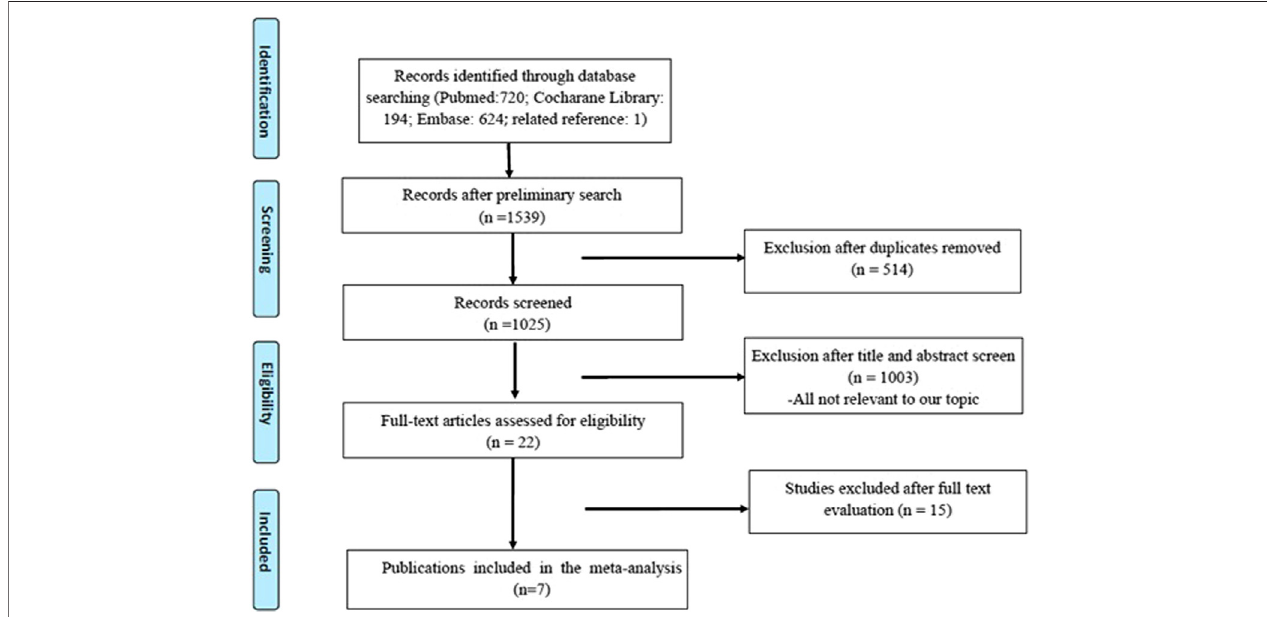
FIGURE 1 | Flowchart for article